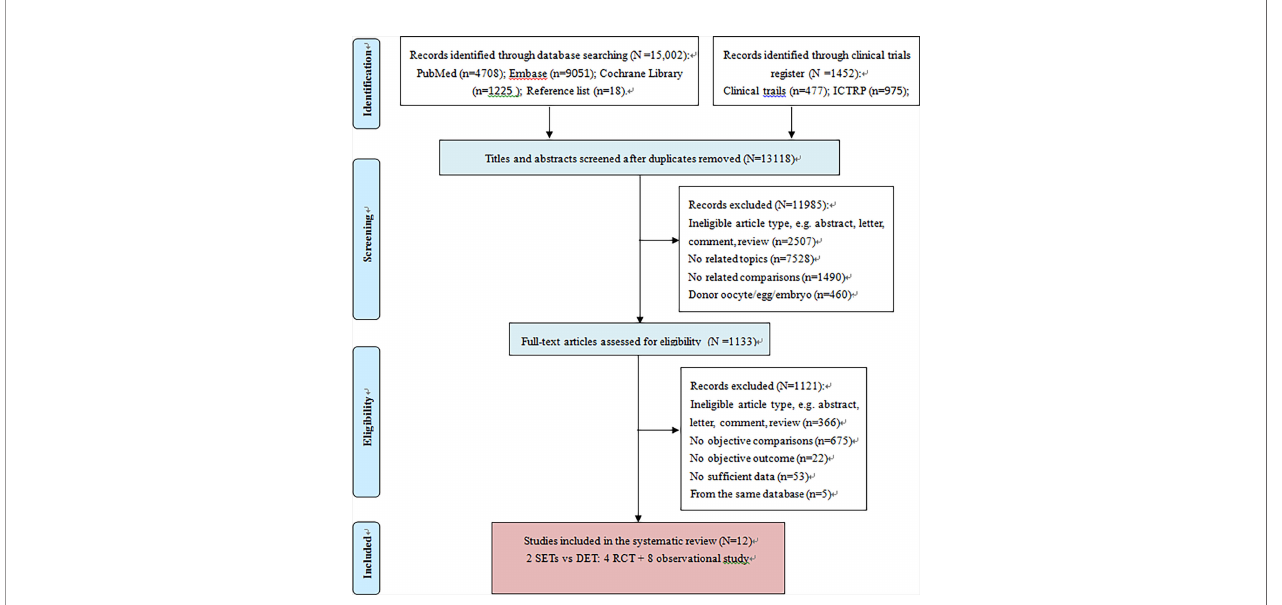
FIGURE 1 | Flow diagram of study selection. DET, double embryo transfer; ICTRP, International Clinical Trials Registry Platform; SET, single embryo transfer; 2SETs, two consecutive cycle of SET; RCT, randomized controlled